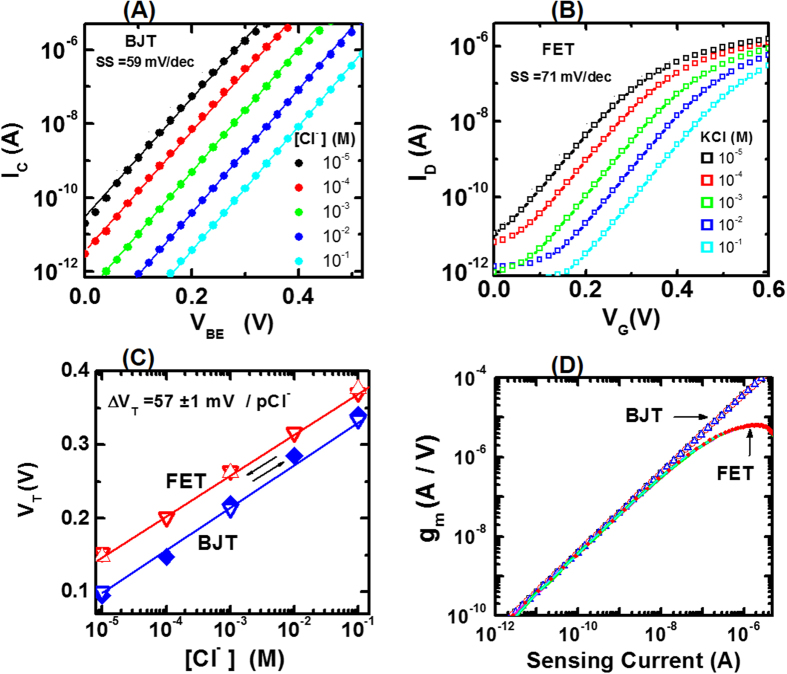
Sensing measurements using BJT and FET electrochemical sensors.(A) Dependence of the sensing signal IC on applied voltage VBE (=VB − VE) in KCl solution of various concentrations for a BJT sensor; symbols are measurements and solid lines are fits. (B) Dependence of the sensing signal ID on applied gate voltage VG in KCl solution of various concentrations for a FET sensor; symbols are measurements and solid lines are fits. (C) Threshold voltage VT dependence on chloride concentration for BJT and FET sensors; VT values are extracted from transfer curves shown in (A) and (B); different symbols denote different VT measurement sets; open symbols indicate that measurements are made as [Cl−] is increased, and filled symbols indicate that measurements are made as [Cl−] is decreased; arrows indicate that VT dependence on chloride concentration is reversible; solid lines are fits and provide estimations of VT shifts (ΔVT) with variation in chloride concentration by a decade: ΔVT = 57 mV/pCl− for both FET and BJT sensors. (D) Transconductance (gm) dependence on sensing current for BJT and FET sensors; IC is the sensing current for the BJT sensor and ID is the sensing current for the FET sensor; gm values are extracted by numerically differentiating transfer curves shown in A and B.